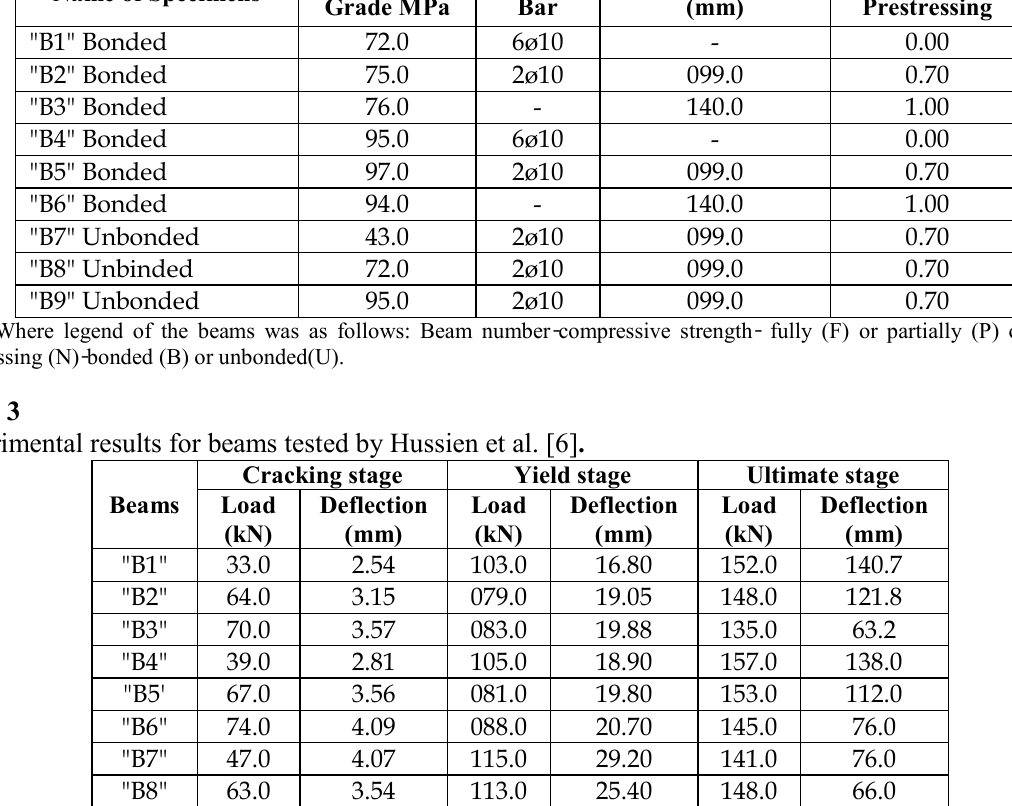
Fig.2. Detail of beams reinforcement tested by Hussien et al. [6]. Specimens Program for beam Tested by Hussien et al. [6]. Name of Specimens